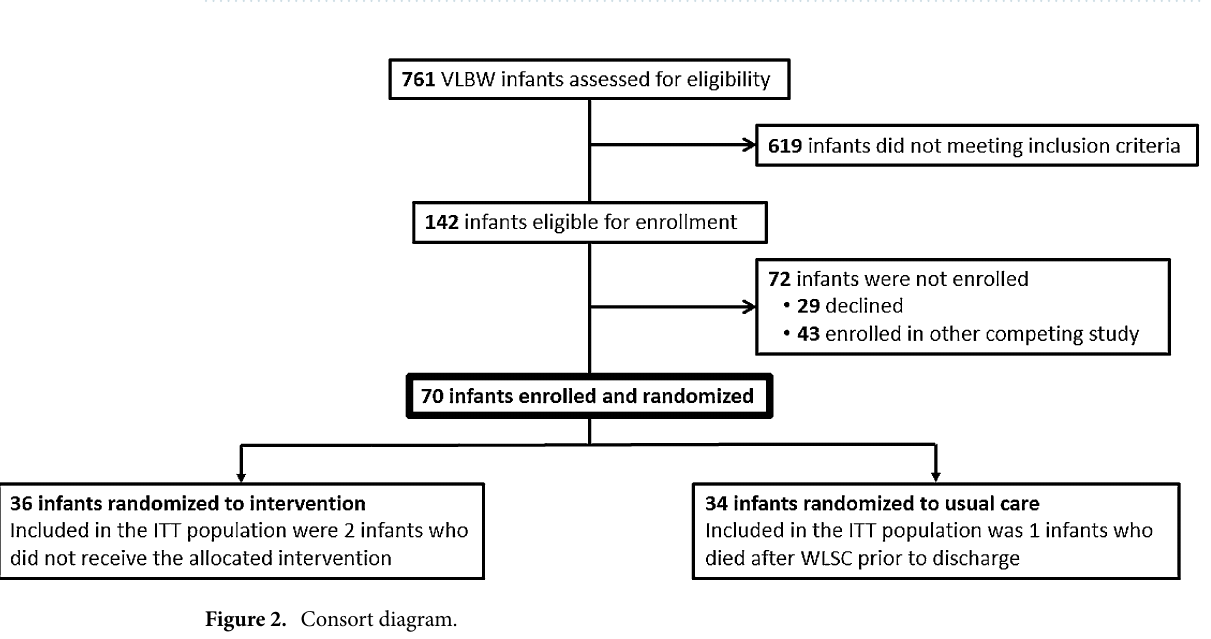
Figure 2. Consort